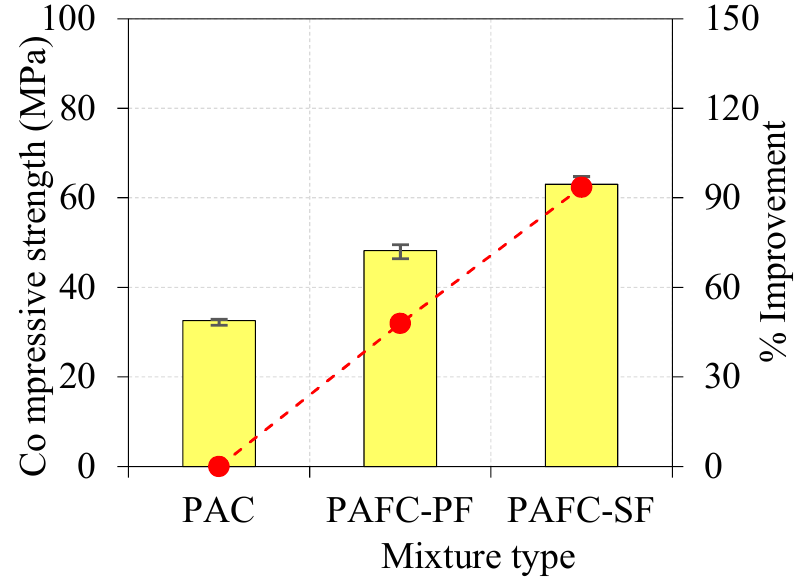
Figure 8. Compressive strength of concrete.